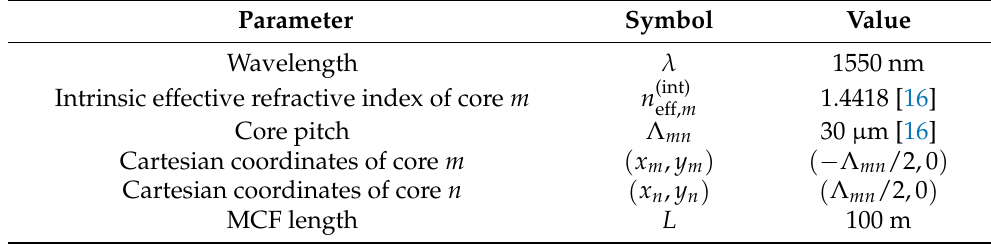
Table 1. Single-mode WC-MCF parameters kept constant in numerical results. Parameter Symbol Value Wavelength λ 1550 nm Intrinsic effective refractive index of core m n (int) 1.4418 [16] eff, m Core pitch Λ mn 30 µ m [16] Cartesian coordinates of core m ( x m , y m ) ( − Λ mn /2, 0 ) Cartesian coordinates of core n ( x n , y n ) ( Λ mn /2, 0 ) MCF length L 100